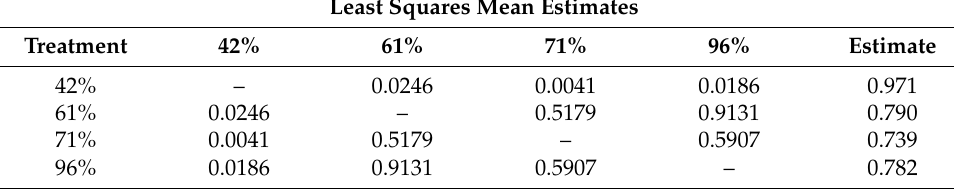
Table 3. Effects of Past Thinning on Tree-ring Widths at Ranger School, 1995–2005. Highlighted p -values indicate significantly different treatment group relationships ( p < 0.05). Least squares mean estimates